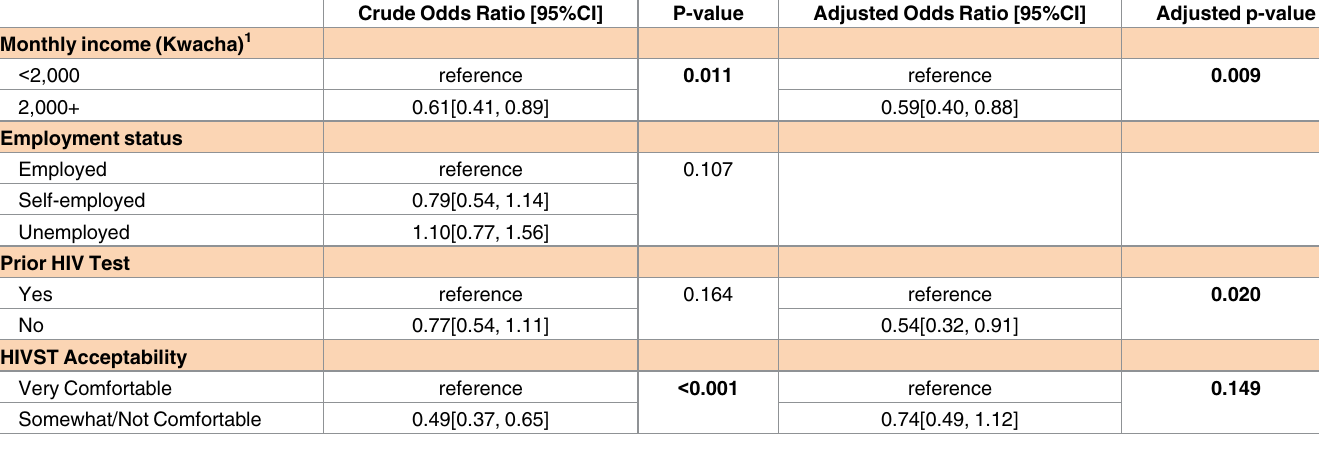
Table 3. Factors independently associated with odds of intention to link to care among respondent aged 16–49 years, Lusaka,